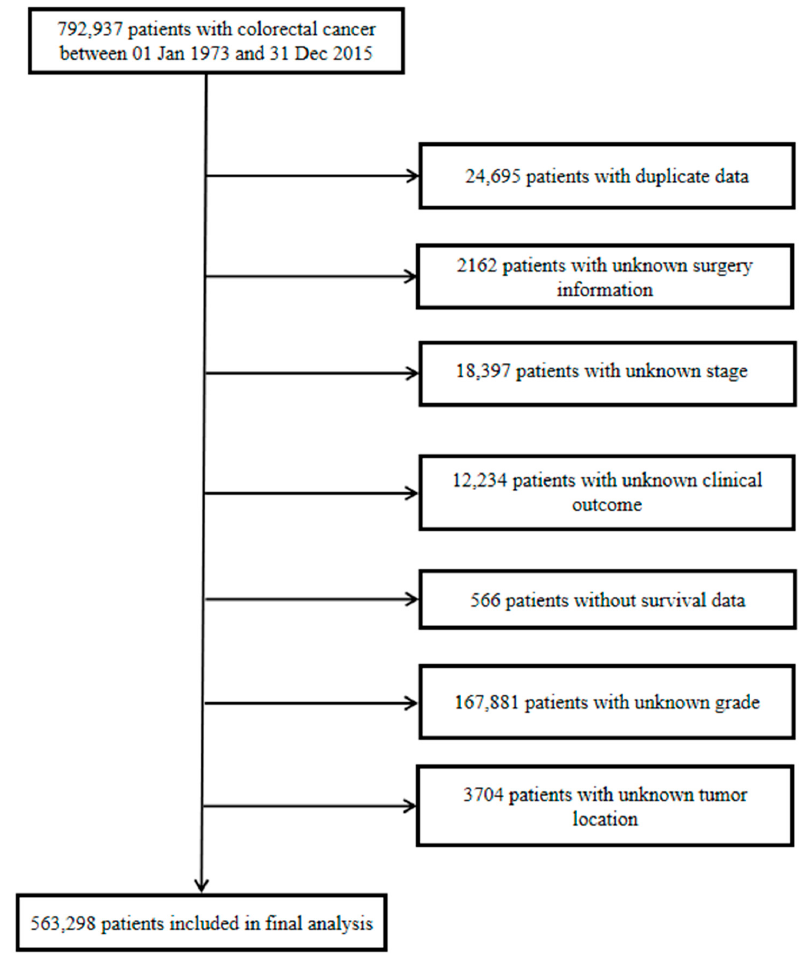
Figure 1. Flowchart of the selection of study subjects.